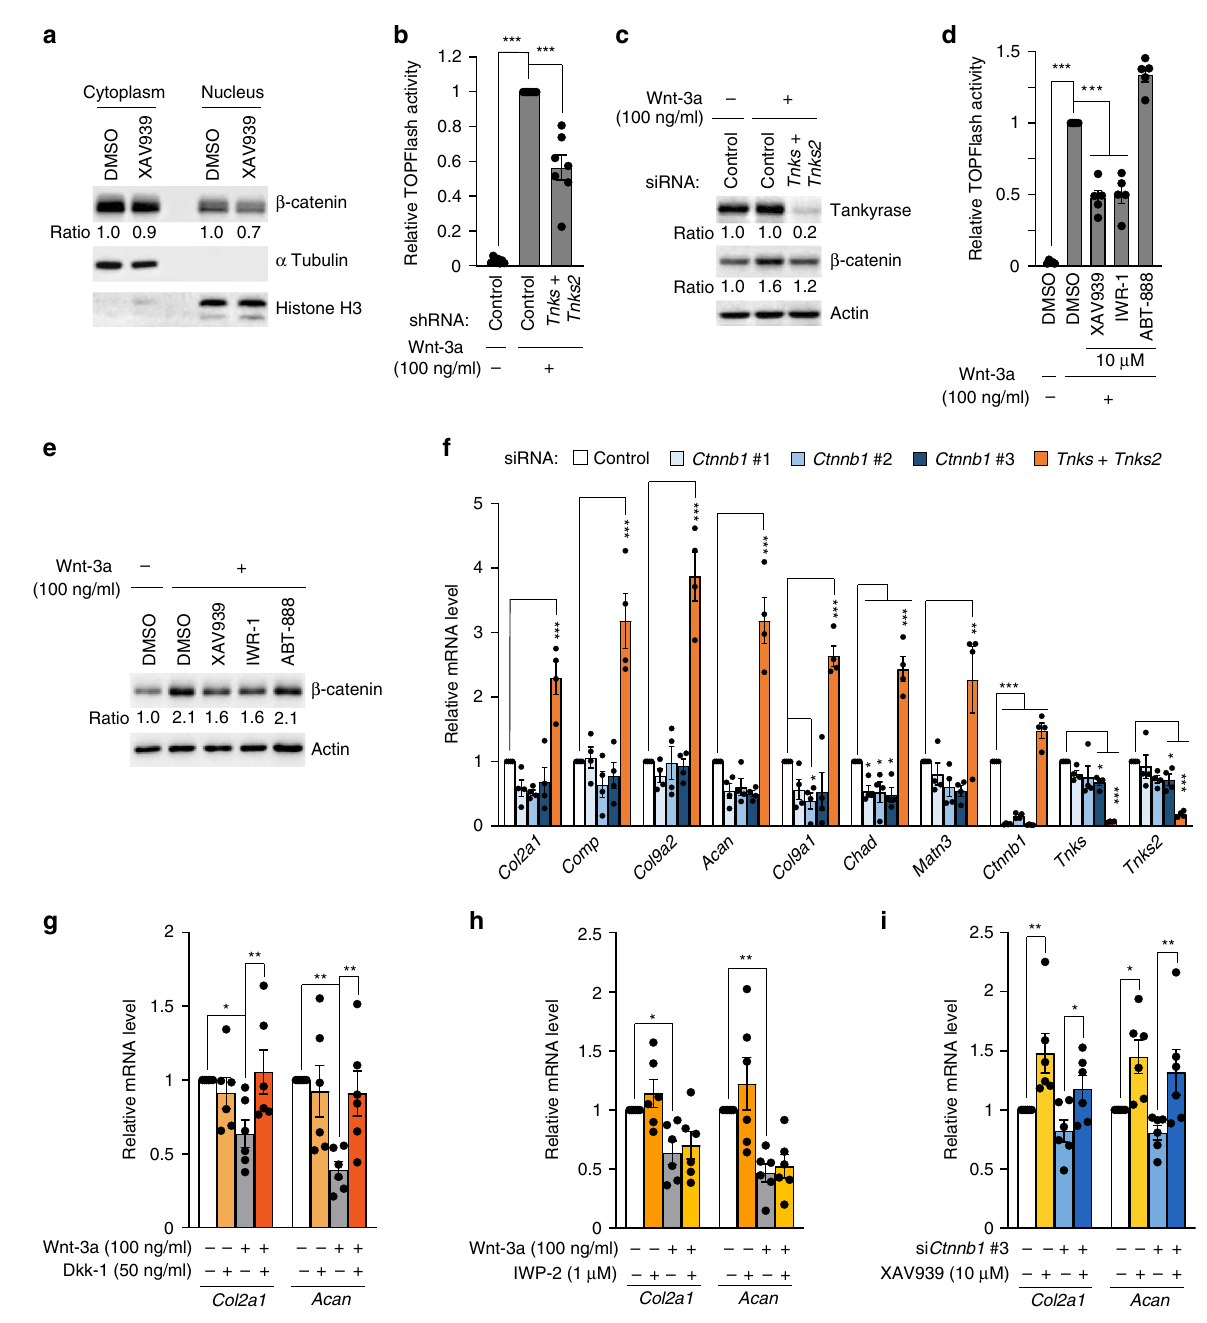
Fig. 2 Pro-anabolic effect of tankyrase inhibition is mediated by a β -catenin-independent pathway. a Cytoplasmic and nuclear fractions from chondrocytes treated with DMSO or XAV939 (10 μ M, 72 h) were immunoblotted for β -catenin. The band intensities were normalized with respect to the DMSO-treated control within each fraction. b TOPFlash reporter assay in chondrocytes after control shRNA or sh Tnks and sh Tnks2 transfection ( n = 7). c Chondrocyte lysates were immunoblotted for β -catenin after treatment with control or Tnks and Tnks2 siRNAs. d TOPFlash reporter assay in chondrocytes following drug treatment (10 μ M, 48 h; n = 5). e Chondrocyte lysates were immunoblotted for β -catenin after treatment with the indicated 10 μ M of drugs for 48 h. b – e Wnt-3a recombinant protein was added 24 h before harvest. f mRNA levels of cartilage matrix genes in chondrocytes transfected with control, Tnks and Tnks2 , or Ctnnb1 siRNAs ( n = 4). si Ctnnb1 #3 was used throughout this study. g – i mRNA levels of Col2a1 and Acan in mouse chondrocytes treated with g Dkk-1 and Wnt-3a for 72 h ( n = 6), h IWP-2 and Wnt-3a for 72 h ( n = 6), or i control siRNA or si Ctnnb1 #3 followed by DMSO or XAV939 treatment for 72 h ( n = 6). b , d , f – i Data represent means± s.e.m. * P < 0.05, ** P < 0.01, *** P < 0.001 by ANOVA. a , c , e The relative protein band intensity is indicated. Full-size immunoblot images are provided in Supplementary Fig.